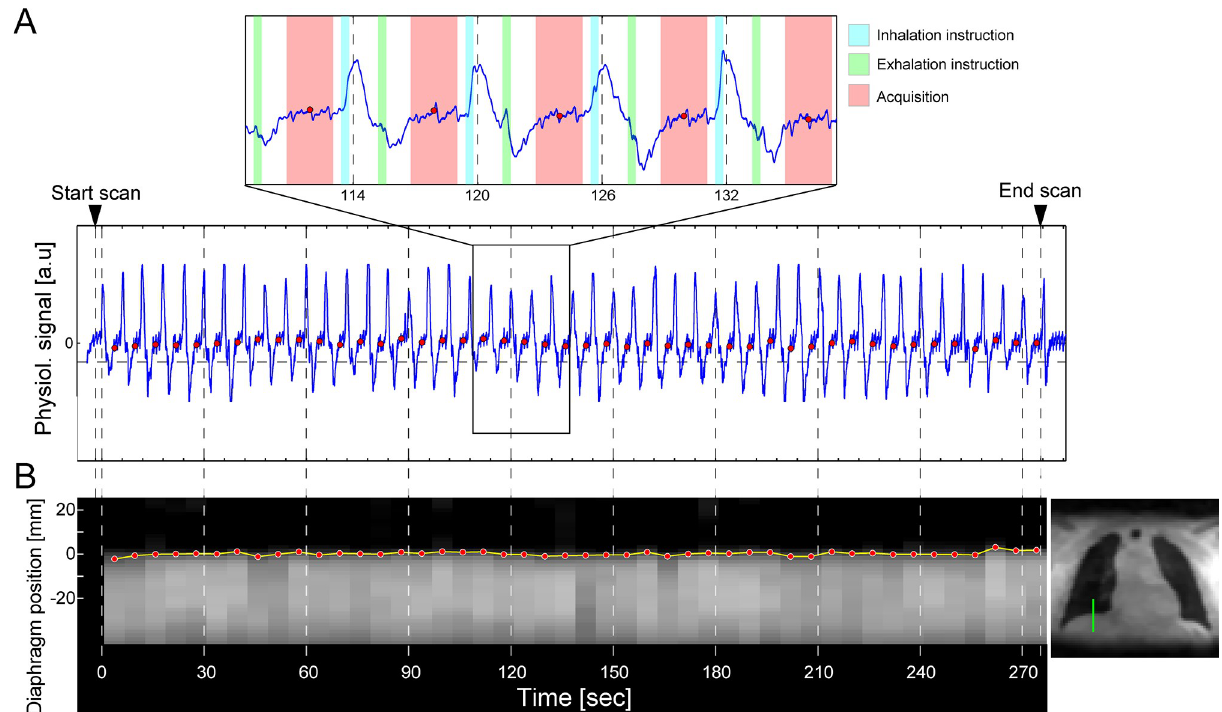
Fig 2. Validation of sound respiration guide. A) Physiological signal recorded with a respiratory bellows during a sound-guided UTE MRI scan shows a regular 6-second period pattern (blue line; lower panel), where sharp peaks represent the onset timings of inhalation. The physiological signal started rising up when the breathe-in instructions (right blue area; upper panel) were turned on and physiological signal drops were detected following the breathe-out instructions (right green area). Data acquisition (red area) was performed during the latter half of the exhalation period right before the subsequent breath-in instruction. Red points represent the center of the UTE acquisition periods. B) Diaphragm positions obtained from breath-by- breath 3D image series reconstruction of the sound-guided UTE MRI scan. Diaphragm position tracked with the lung-liver interface at the top flat region of the right hemidiaphragm (green line in the right image) stayed at a similar position in every breath.